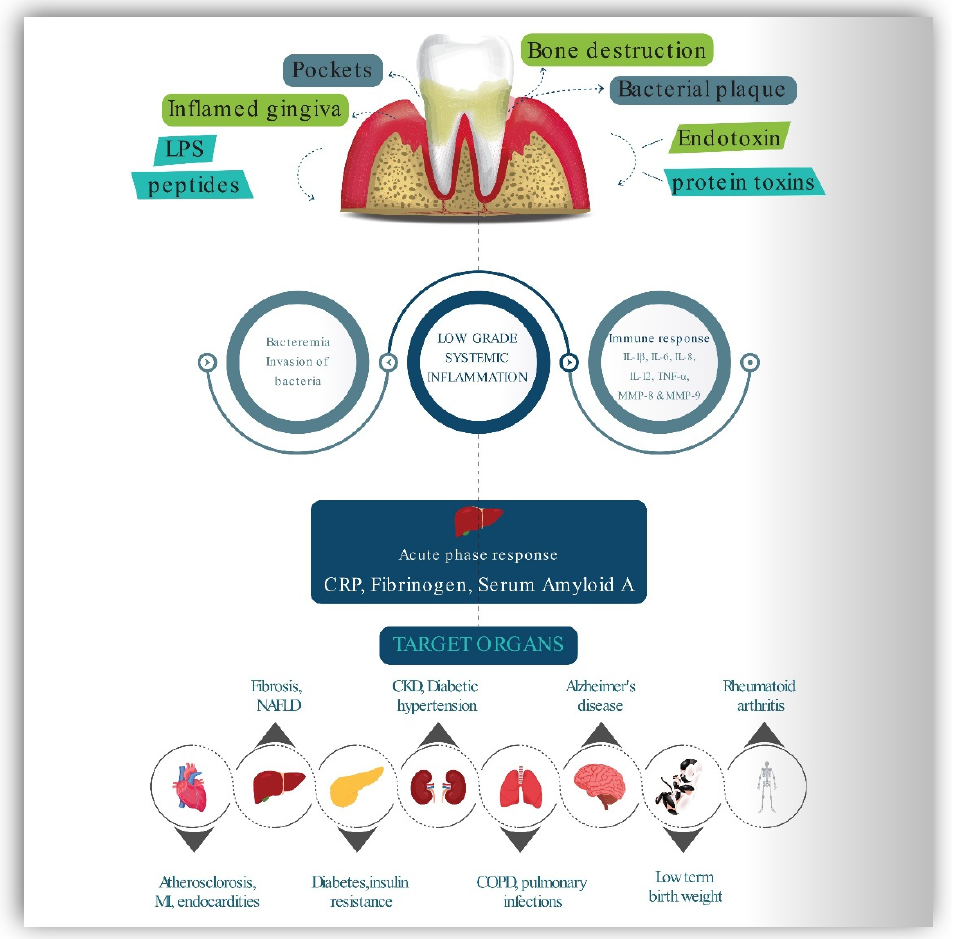
Figure 3. The relationship between periodontal disease and other systemic disorders.